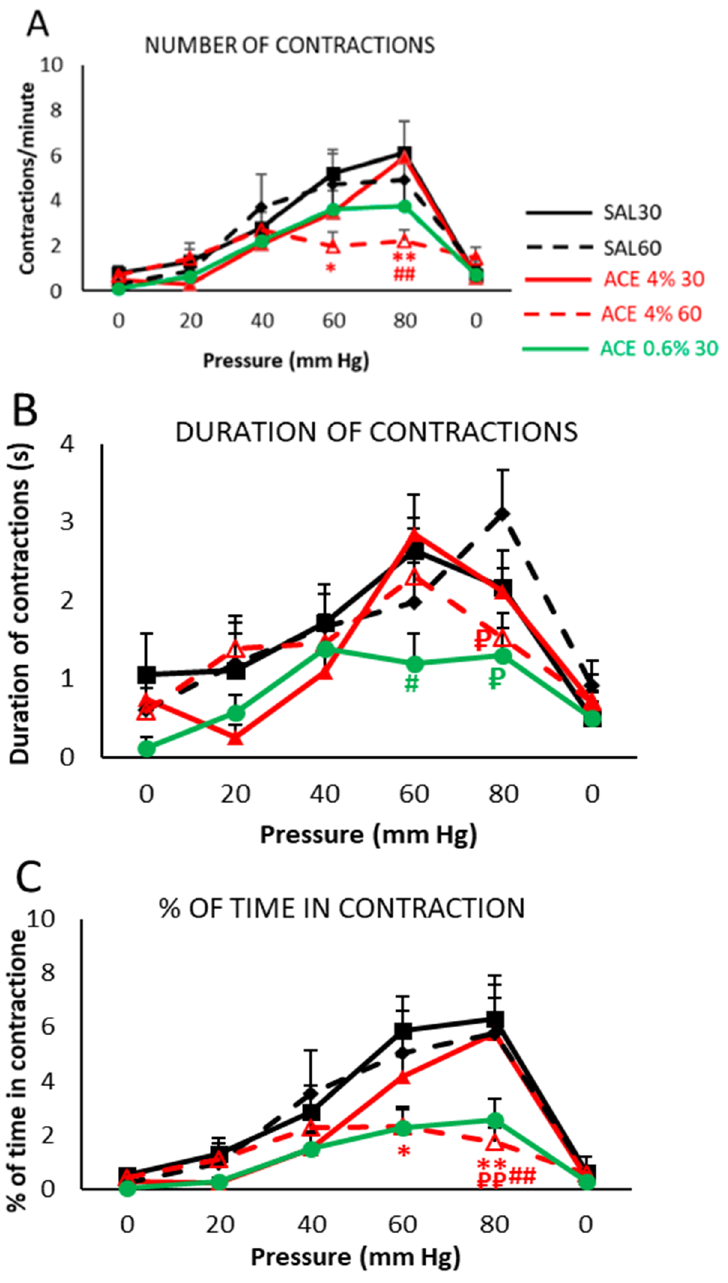
Figure 2. Effect of intracolonic administration of acetic acid on visceral sensitivity, phase I (model selection). Animals were subjected to tonic mechanical intracolonic stimulation. Pressure was increased from 0 to 80 mm Hg, in steps of 20 mm Hg every 5 min, to finally return to 0 mm Hg again; for each pressure value, a single stimulus was applied and maintained for 5 min. Number of contractions per minute ( A ), duration of contractions ( B ), and percentage of time in contraction ( C ) were measured. Animals ( n = 8–13/group) were intracolonically administered with saline (control, SAL) or acetic acid (ACE) at two different concentrations: 0.6% or 4%. The visceral sensitivity test was performed at two different time points after administration: 30 (SAL30, black line/ACE 0.6% 30, green line/ACE 4% 30, red line) or 60 min (SAL60, black dotted line /ACE 4% 60, red dotted line). Data represent the mean ± SEM. * p < 0.05 vs. SAL30; ** p < 0.01 vs. SAL30; ₽ p < 0.05 vs. SAL60; ₽₽ p < 0.01 vs. SAL60; # p < 0.05 vs. ACE 4% 30, ## p < 0.01 vs. ACE 4% 30. Two-way ANOVA followed by Bonferroni post hoc test ( n = 8–13).